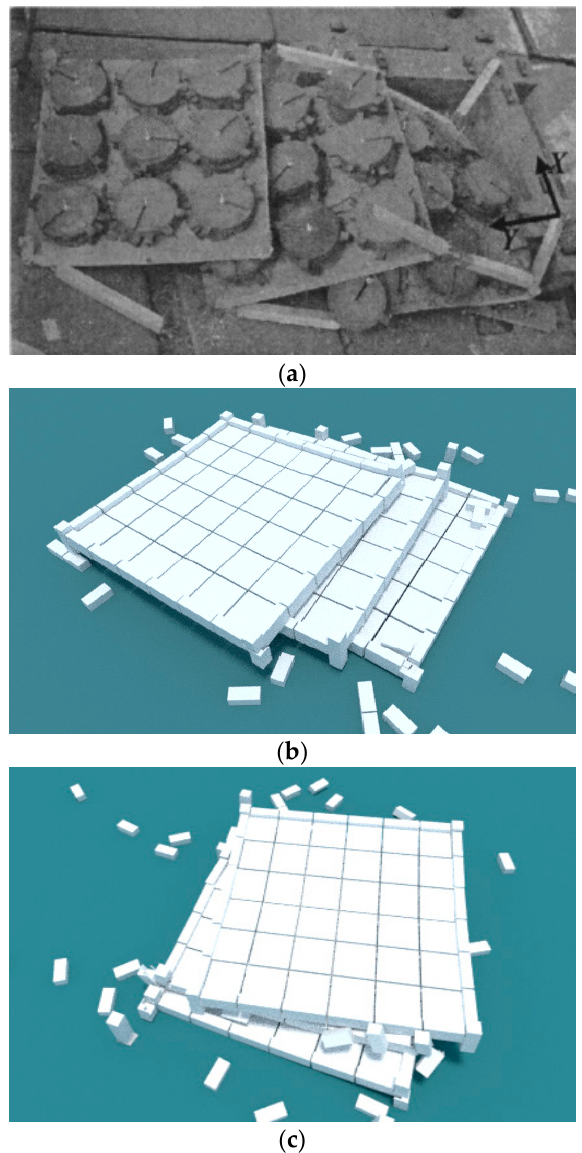
Figure 11. Distribution of ruins: ( a ) test; [20] (Reproduced with permission from Huang, Q., from Study on spatial collapse responses of reinforced concrete frame structures under earthquake ; published by Tongji Univerity, 2006.) ( b ) the proposed FE and BCB hybrid method; ( c ) BCB.